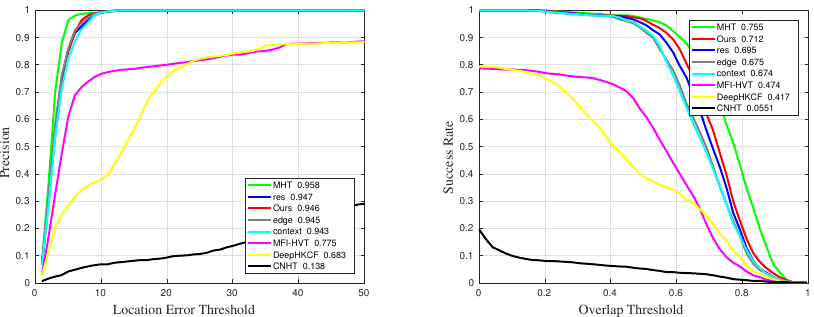
Figure 21. Precision and success rate under OPR